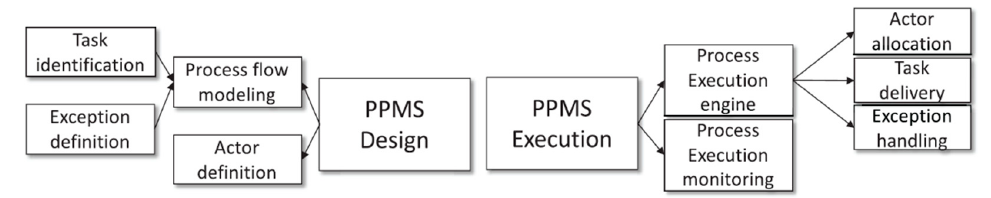
Figure 5. Overview of PPMS functionality [33].